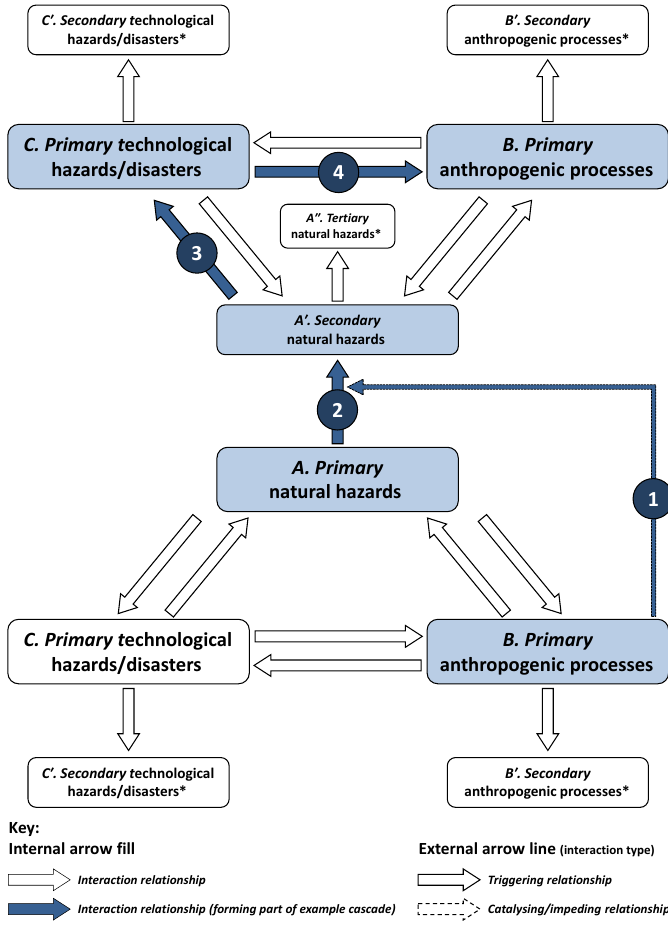
Figure 6. Network of hazard interactions (example A) using a hazard/process flow diagram. Using the visualisation frameworks constructed in Figs. 2 and 3, an example of an interaction network (cascade) can be presented. Three hazard/process groups are included: (A) natural hazards, (B) anthropogenic processes and (C) technological hazards/disasters. Arrows are used to illustrate interaction relationships, with both triggering relationships (thick block arrows with solid outlines) and relevant catalysing/impedance relationships (thin block arrows with dashed outlines). For clarity of communication, those catalysing/impedance relationships not of relevance to the specific example are not included. See caption explanations in Figs. 2 and 3 for further details. Arrows within the example network of hazard interactions are labelled (1–4) and shaded dark blue to highlight the relevant pathway. In this example, a primary anthropogenic process catalyses (1) the triggering relationship between a primary and secondary natural hazard (2), with the secondary natural hazard then triggering (3) a primary technological hazard, which in turns triggers (4) a primary anthropogenic process to